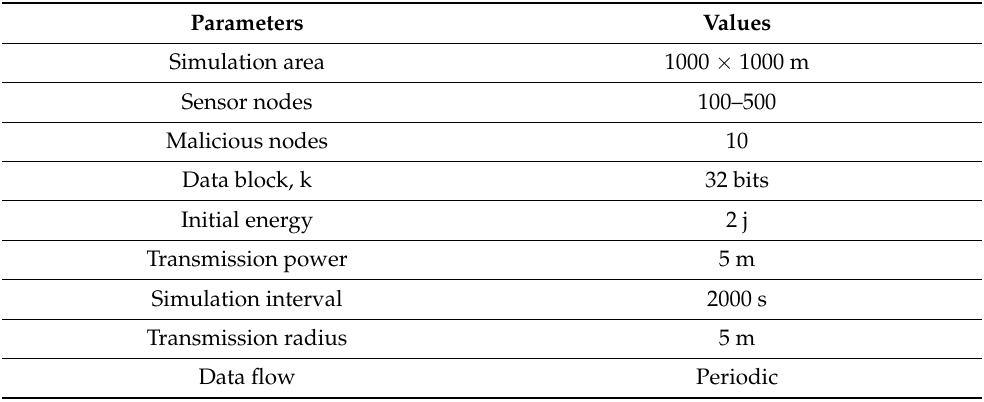
Table 1. Default